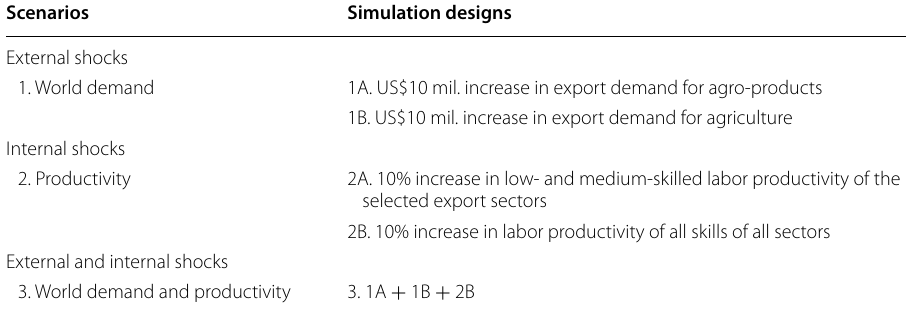
Table 7 Simulation